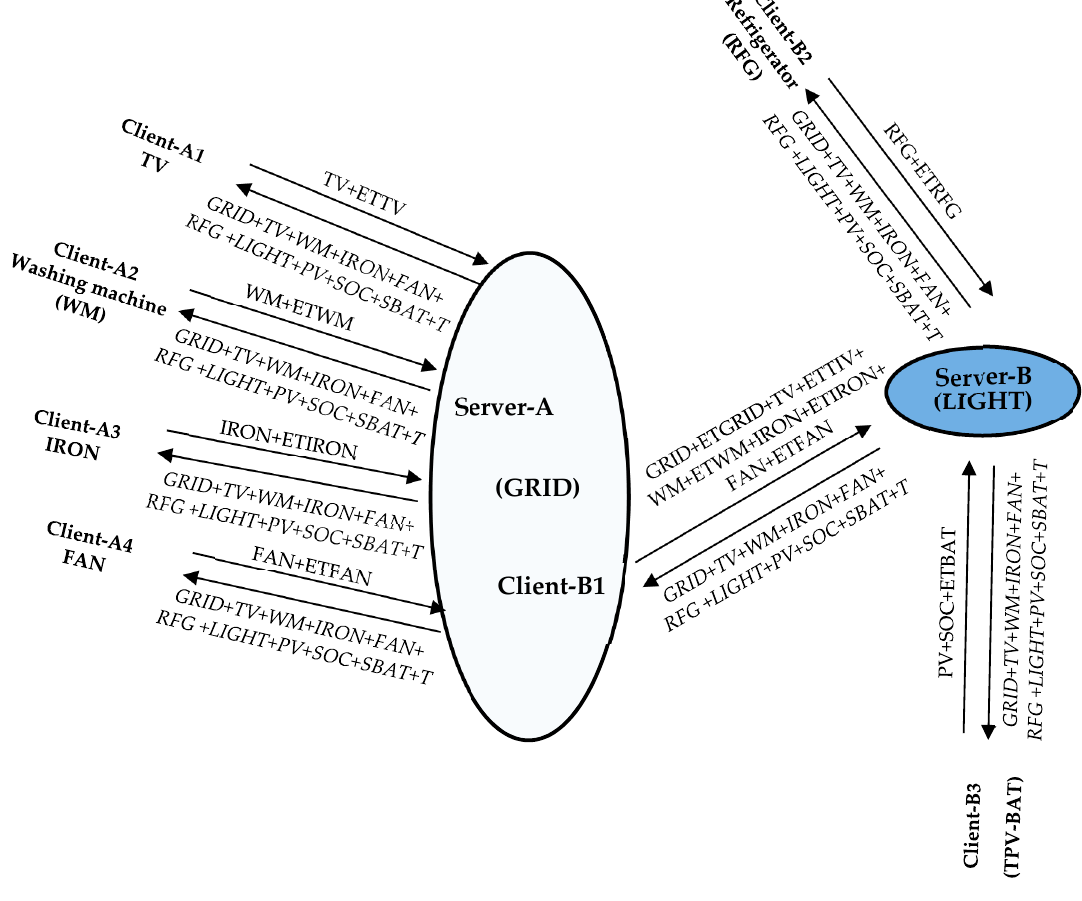
Figure 6. Data communication protocol.